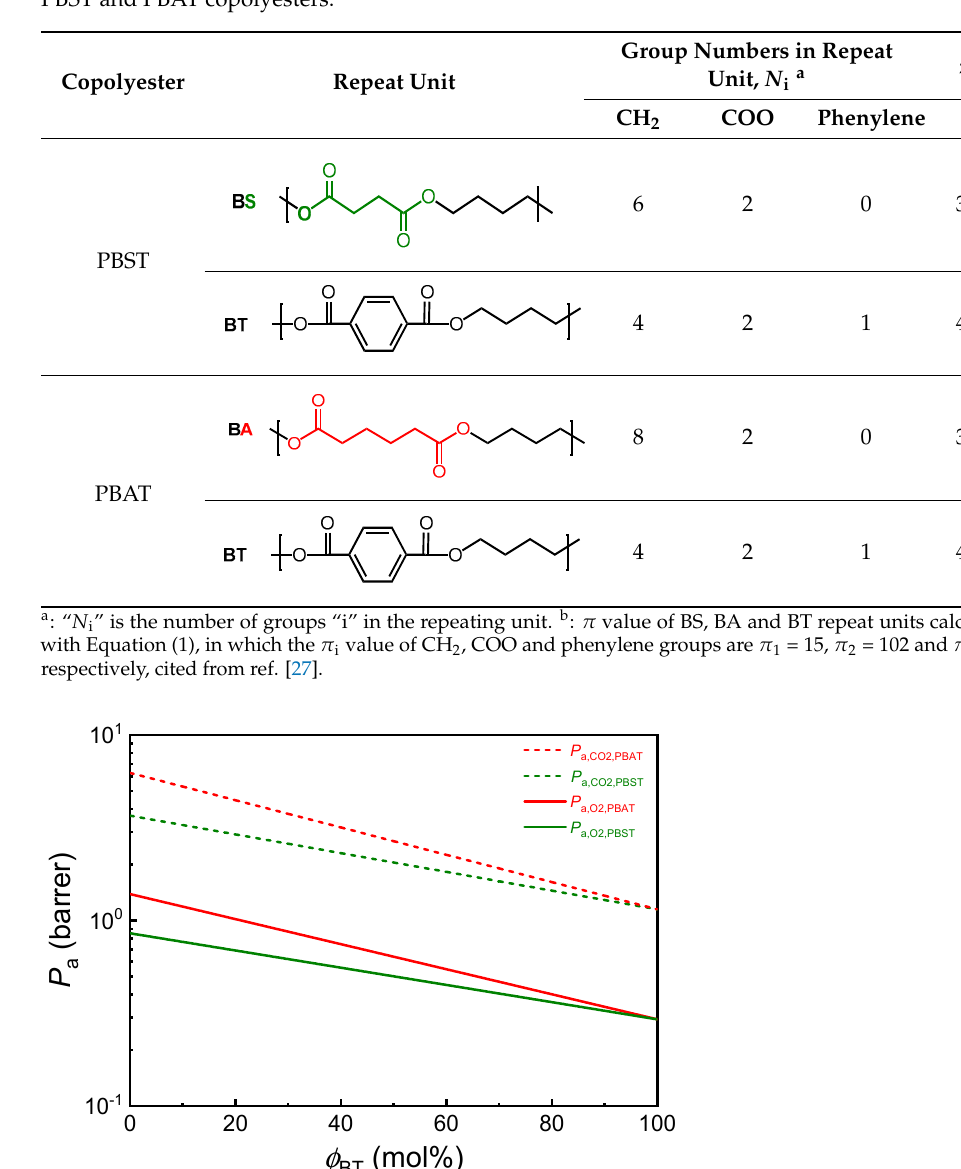
Table 1. Repeat units, group numbers in repeat units and physical quantity “ π ” of repeat units of PBST and PBAT copolyesters.